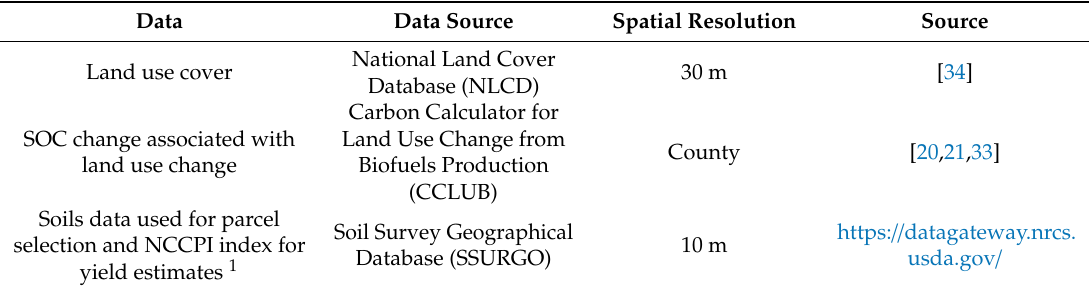
Table 2. Raster data source, spatial resolution, and source used in land use change